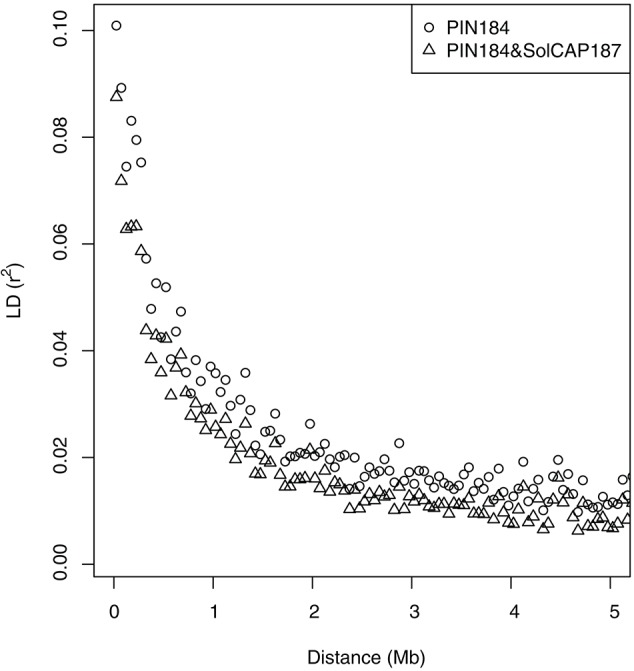
Decay of linkage disequilibrium (LD, r2) with distance between pairs of SNPs. LD averaged over chromosomes is given in distance bins of 50 kb.